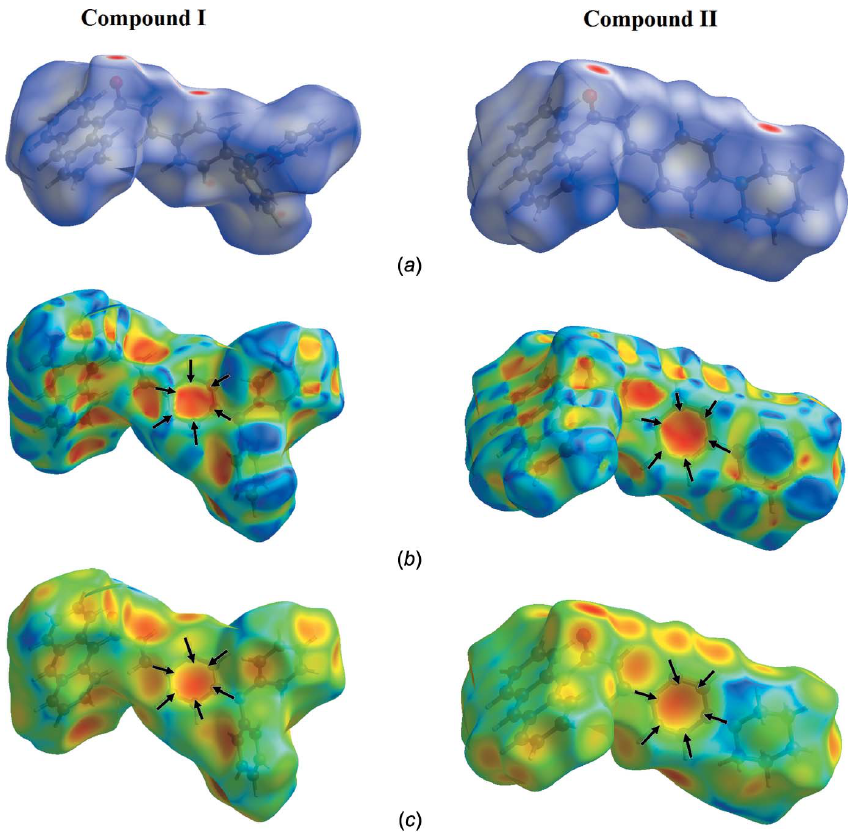
Figure 6 View of the Hirshfeld Surfaces, showing ( a ) d norm with the red spot showing the involvement of the C—H (cid:2)(cid:2)(cid:2) O interactions, ( b ) mapped over shape-index and ( c ) mapped over d e with the pale-orange spot inside the black arrows indicating the C—H (cid:2)(cid:2)(cid:2) (cid:2)